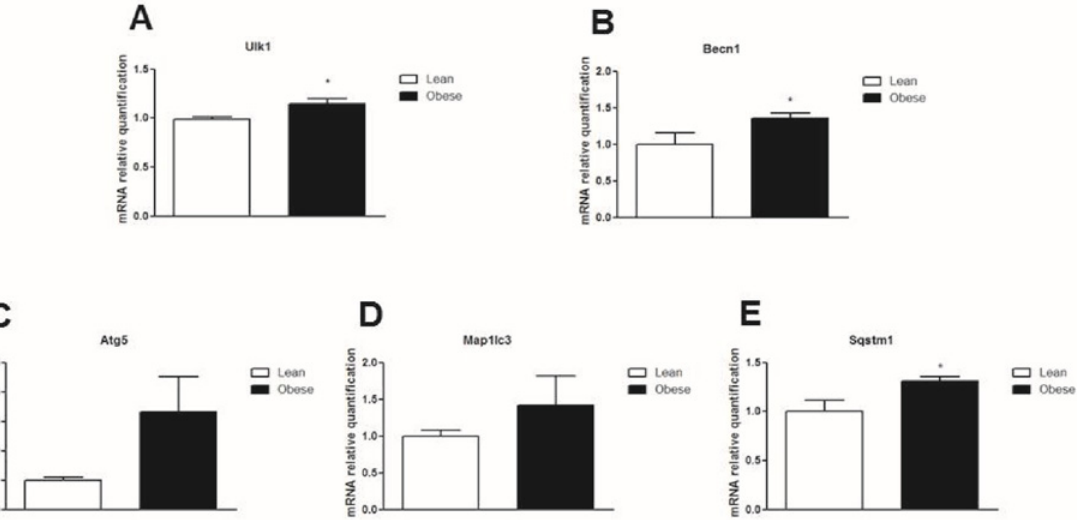
Fig 4. mRNA gene expression of autophagic proteins in the hypothalamus of obese mice. QRT-PCR was used to analyze the gene expression of A. Ulk1, B. BECN-1, C. ATG5, D. Map1lc3 and E. SQSTM1 in the hypothalamus of diet induced obese mice (16 weeks on a HFD) versus lean mice. Values are shown as mean ± SEM. * P < 0.05; n = 6 animals per